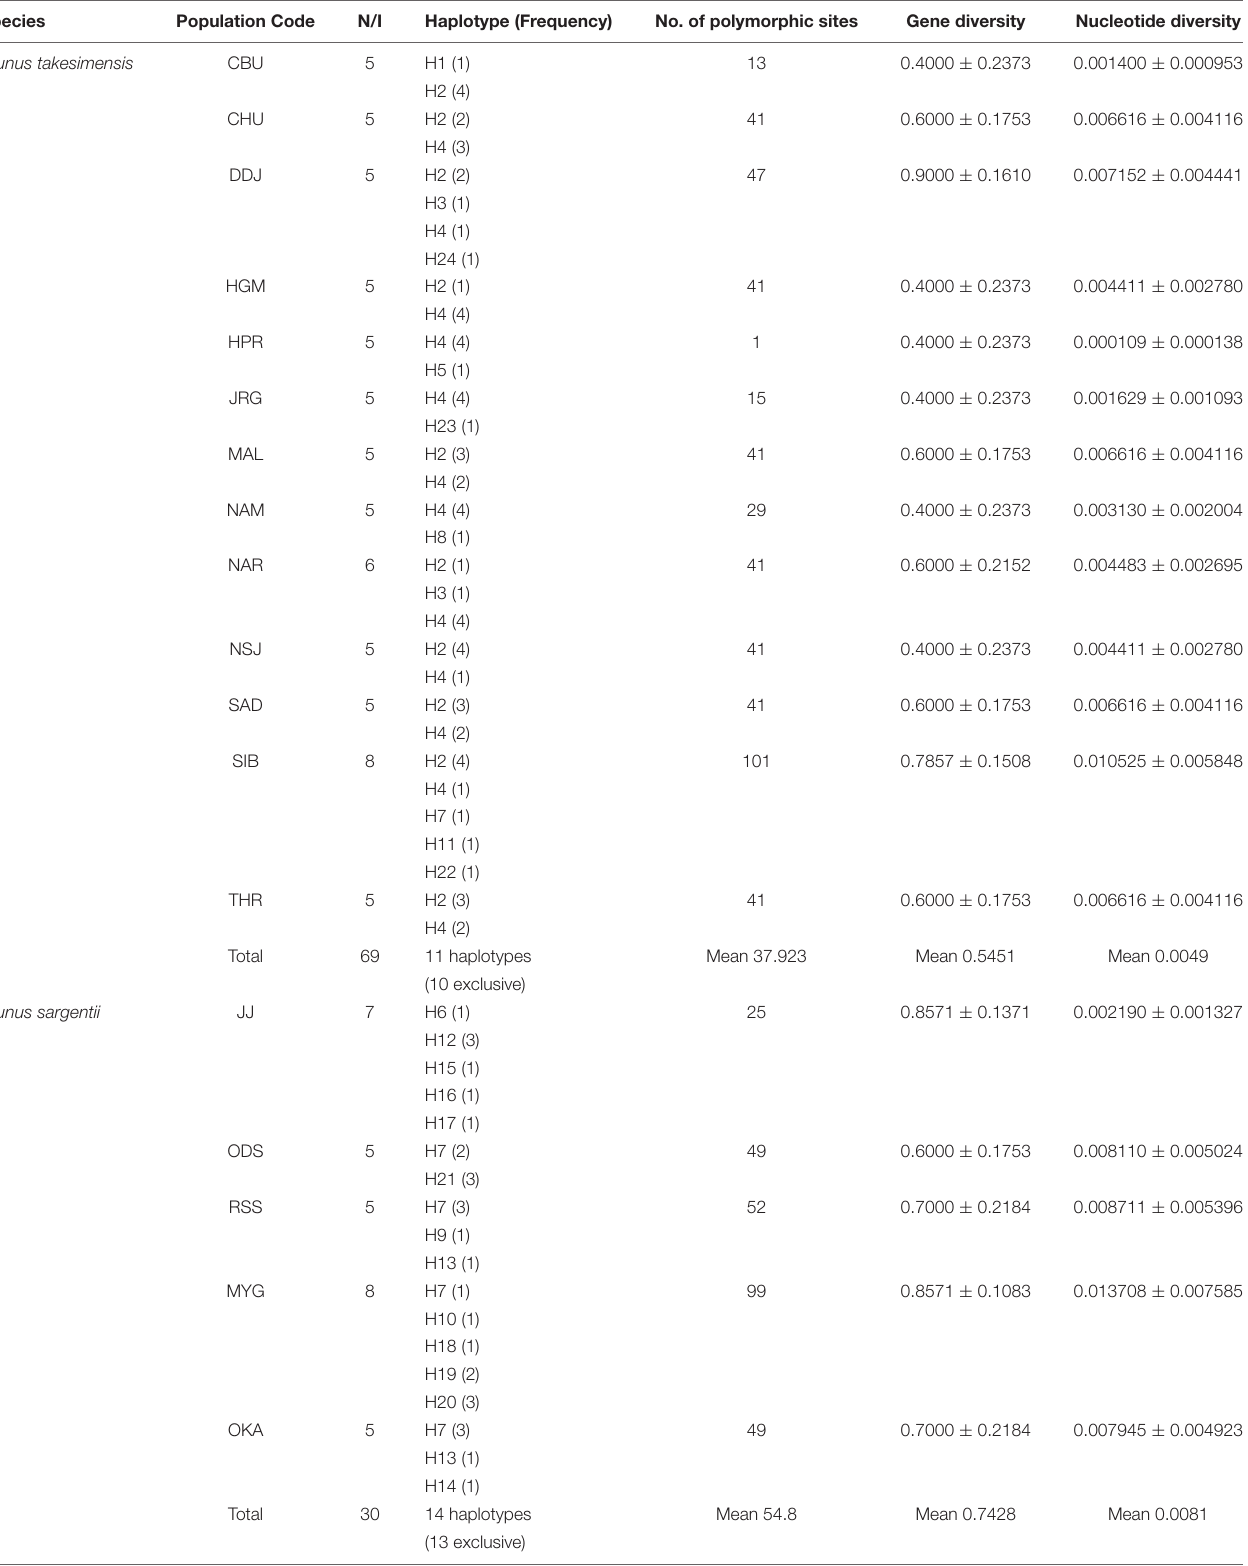
Population code: please refer to Table 1 for exact localities of each population. N/I, number of individuals sampled in this population at this site.